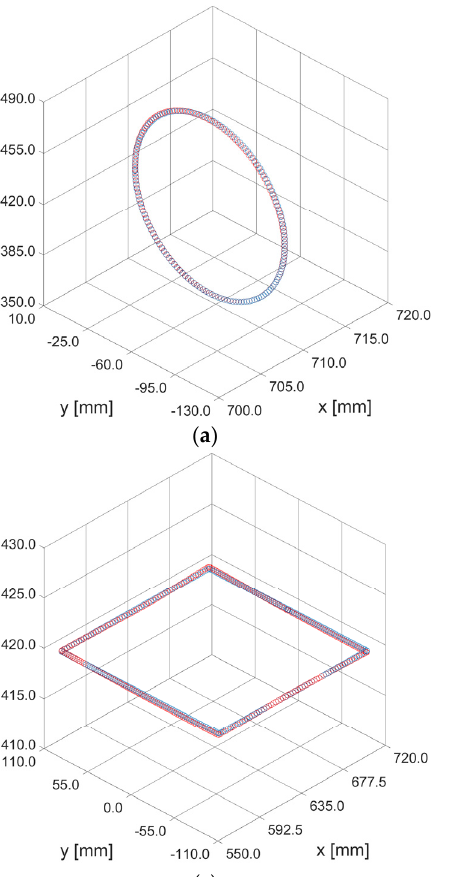
Figure 7. Circle in the Y-Z plane: X-, Y-, Z- axes Virtual IRB140 vs. IK procedure.